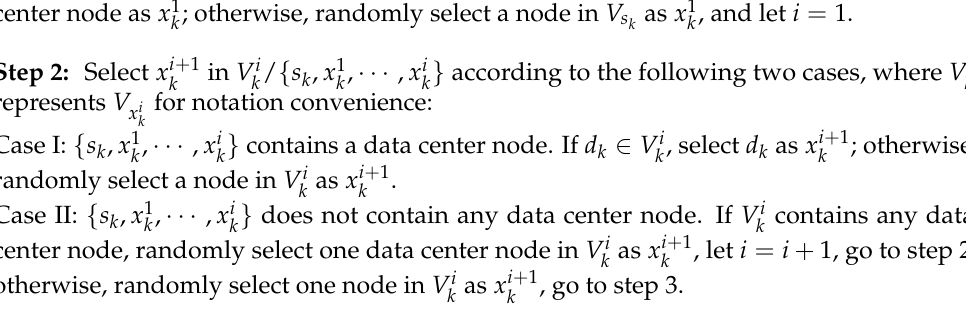
Algorithm 1 Path search